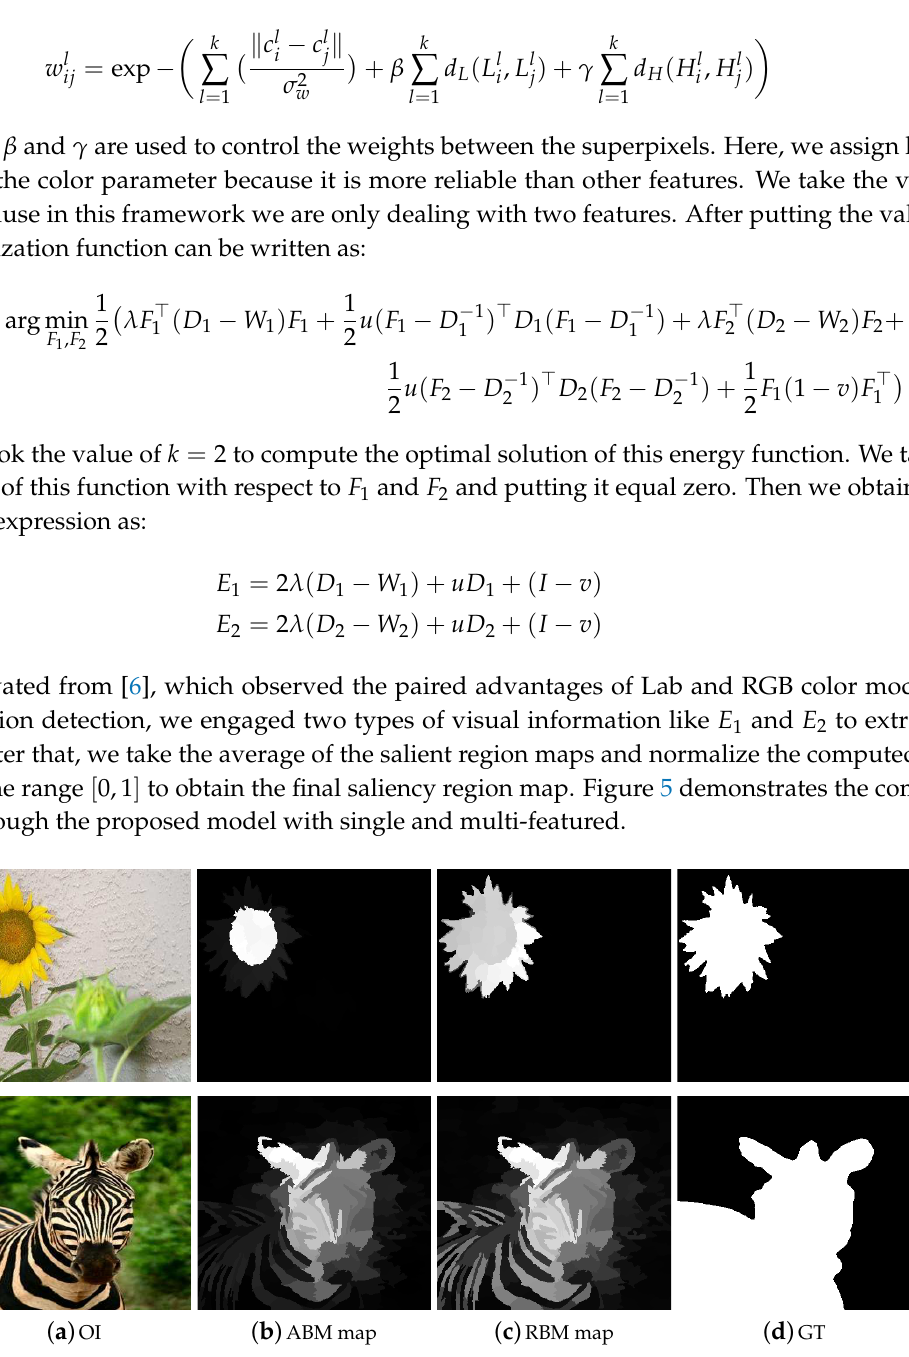
Figure 5. Some examples demonstrating the difference between single and multi-level cues integration step. The results are arranged as OI, salient region map with single feature integration, and the saliency map extracted through multi-label features